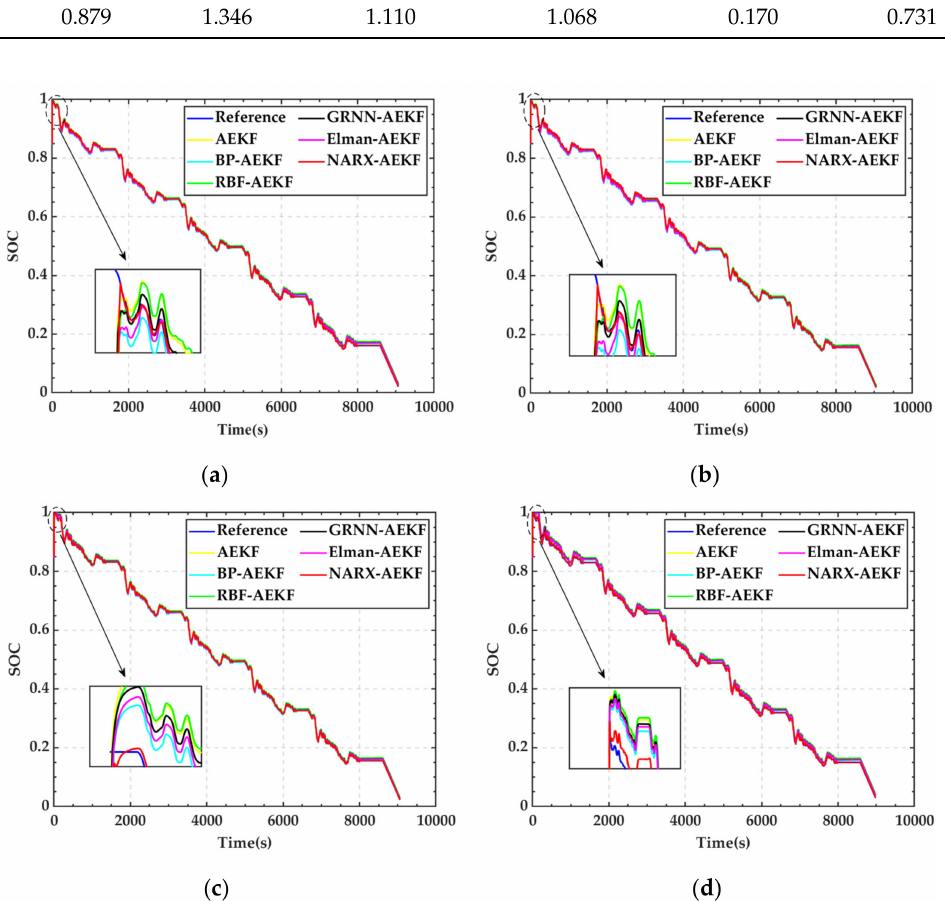
Figure 9. The estimation results of different SOC fusion estimation methods: ( a ) SOC estimation results at − 10 ◦ C; ( b ) SOC estimation results at 10 ◦ C; ( c ) SOC estimation results at 25 ◦ C; ( d ) SOC estimation results at 40 ◦